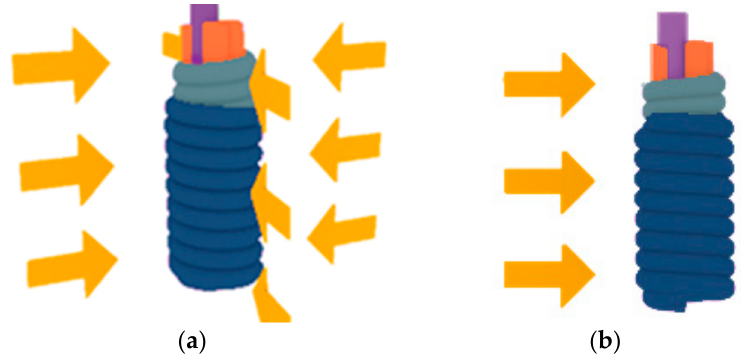
Figure 9. Heat-transfer process of the wrapped yarns in oil-bath ( a ) and hotplate conditions ( b ).